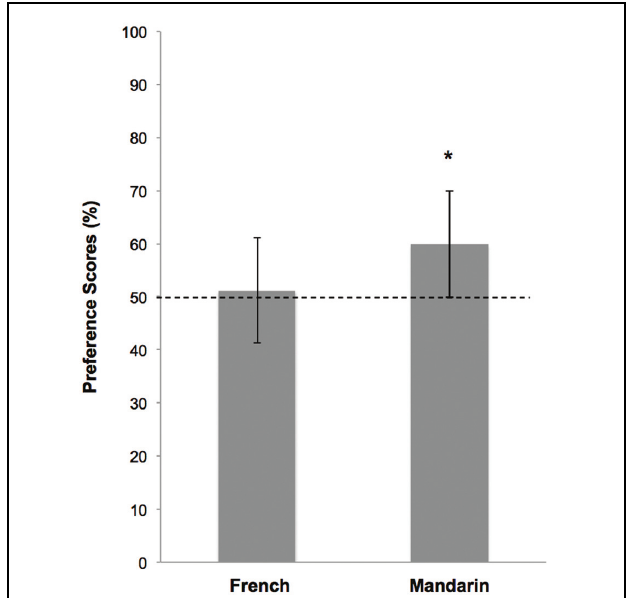
FIGURE 6 | Mean preference scores in the test phase in the F0-modulation condition. Data are shown for the 10-month-old infants learning French and Mandarin. The error bars represent the SE. The dotted horizontal line shows chance level (50% detection). Stars indicate preference scores significantly different from chance ( p <